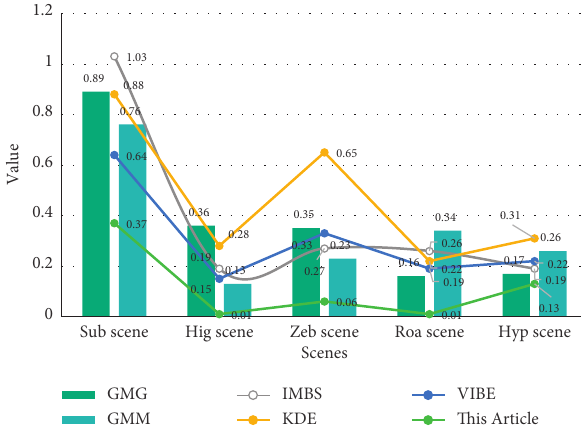
Figure 11: Speed detection indicators for camera shake video li- brary